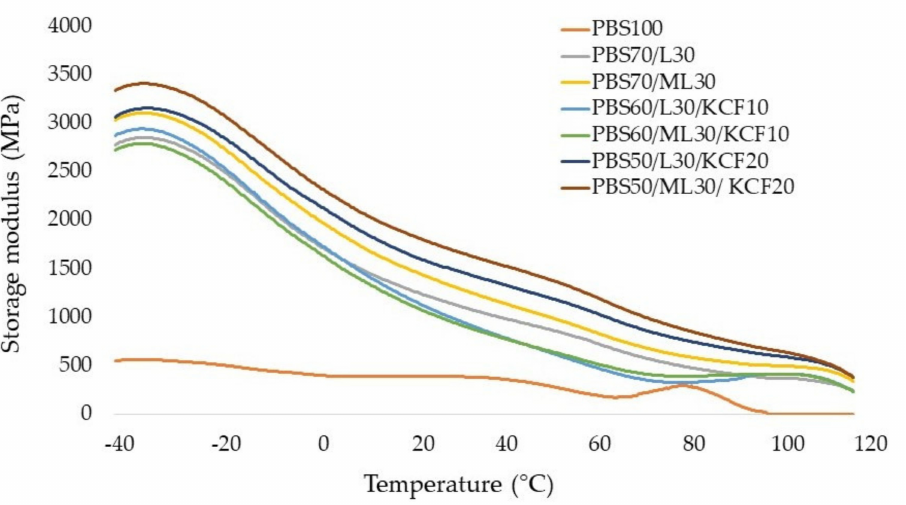
Figure 3. Storage modulus (E’) of the composites prepared from unmodified and modified lignin blend with PBS and kenaf core